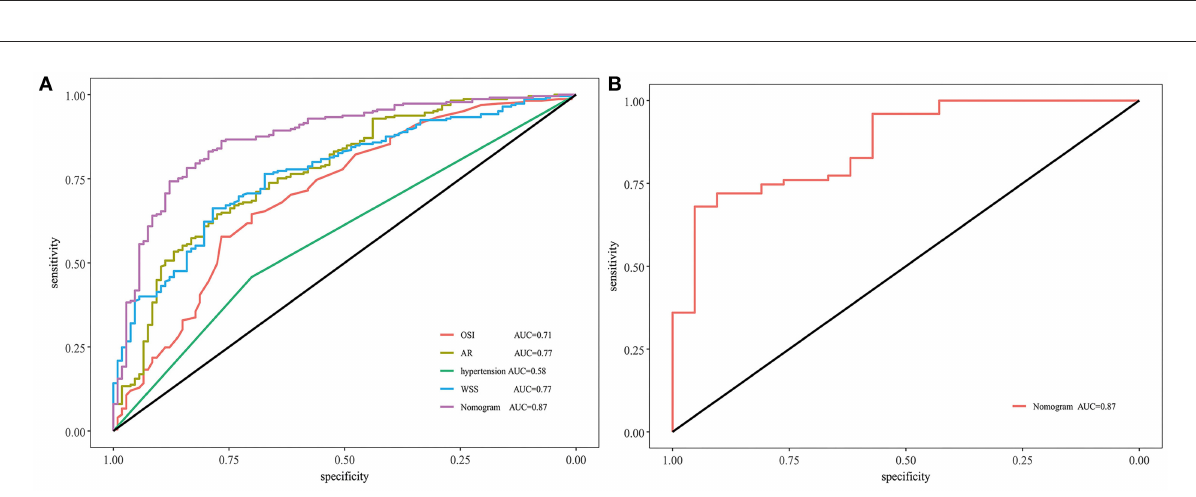
FIGURE3 ROC and AUC analysis for nomogram validation. (A) Internal validation. (B) External validation. ROC, receiver operating characteristic; AUC, area under the curve; AR, aspect ratio; OSI, oscillatory shear index; WSS, wall shear